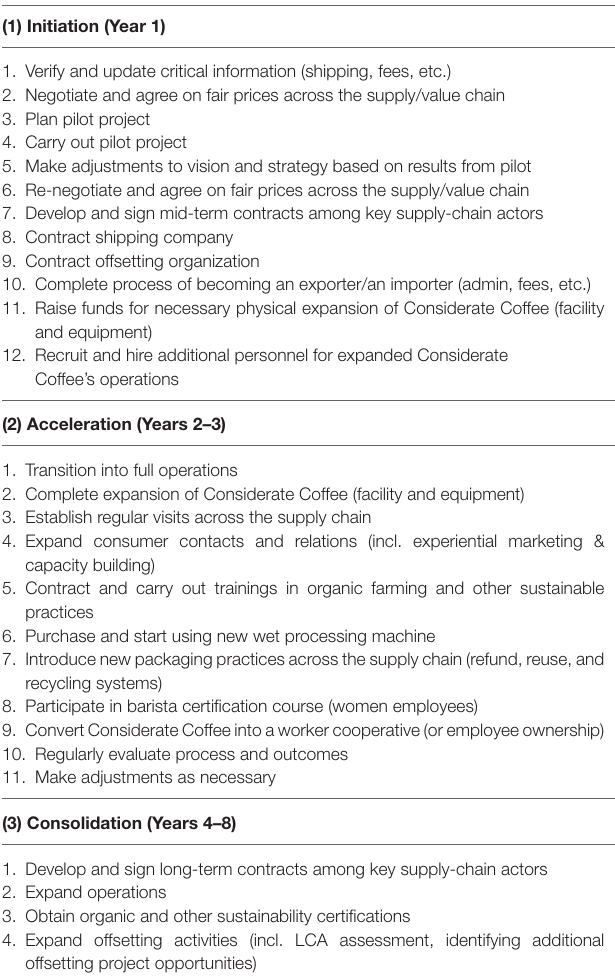
TABLE 3 | Strategy (action plan) for the new supply chain between Considerate Coffee and Catando